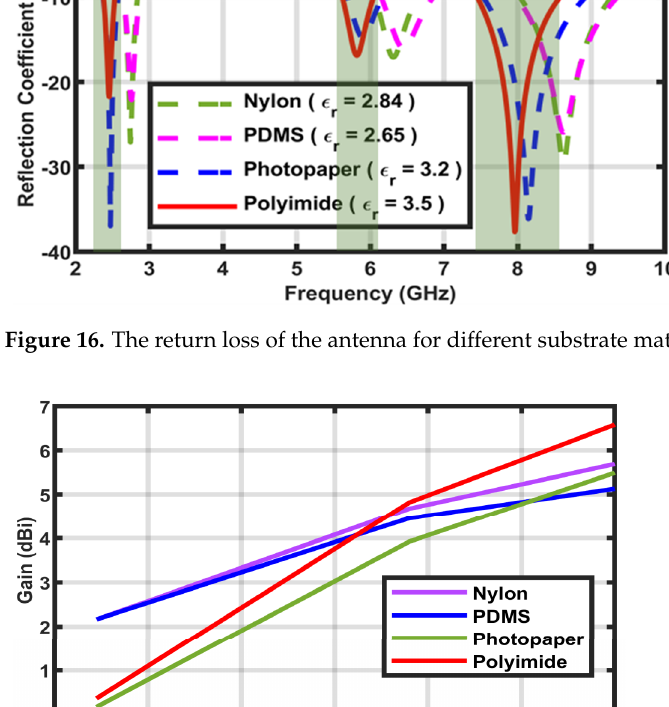
Figure 17. Antenna gain for various substrate materials.